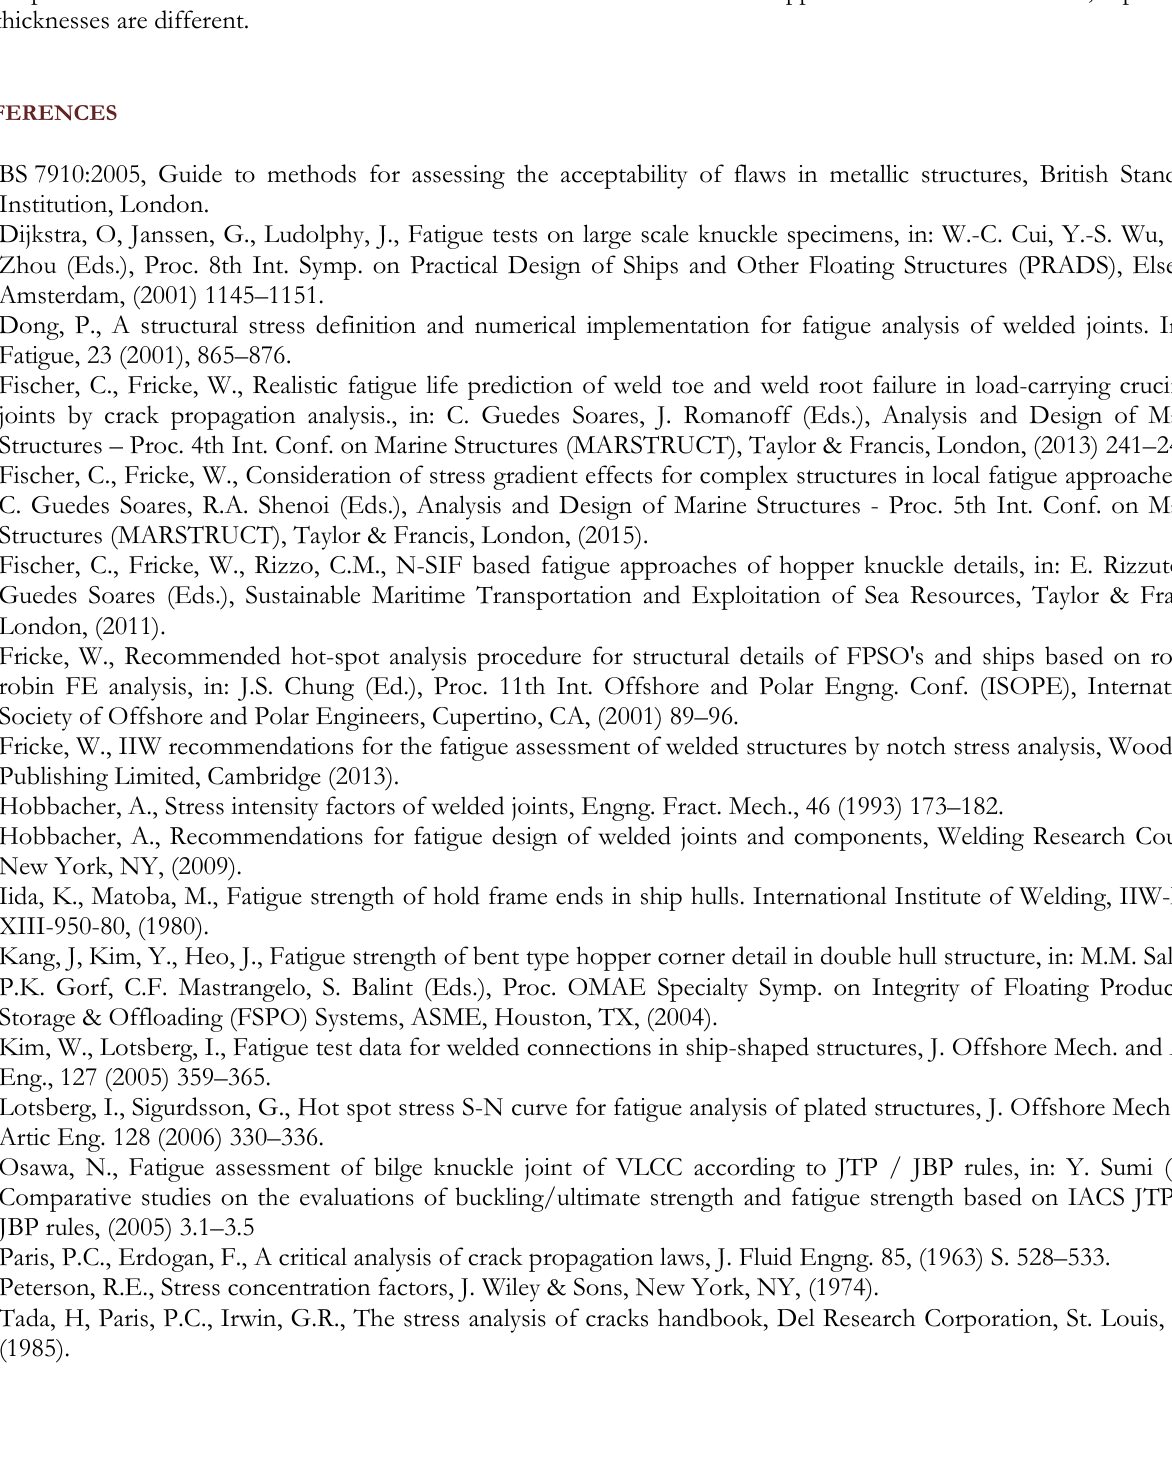
The crack propagation rate at complex structures is slowed down by: the stress gradient over the plate thickness, the apparent plate thickness, the notch effect and the bending constraint of the detail; - The stress gradient along the weld line does not affect the life but the aspect ratio of the semi-elliptical crack shape; - The notch effect depends on the load-carrying grade of weld, the flank angle and of the layout of the transverse attachment and it affects the local stress concentration, leading to longer life. The obtained influences should be investigated for further configurations, varying in particular the thickness of the axially loaded plate as well as of the attachments. This would lead to different local support of the critical weld toe, especially if the thicknesses are